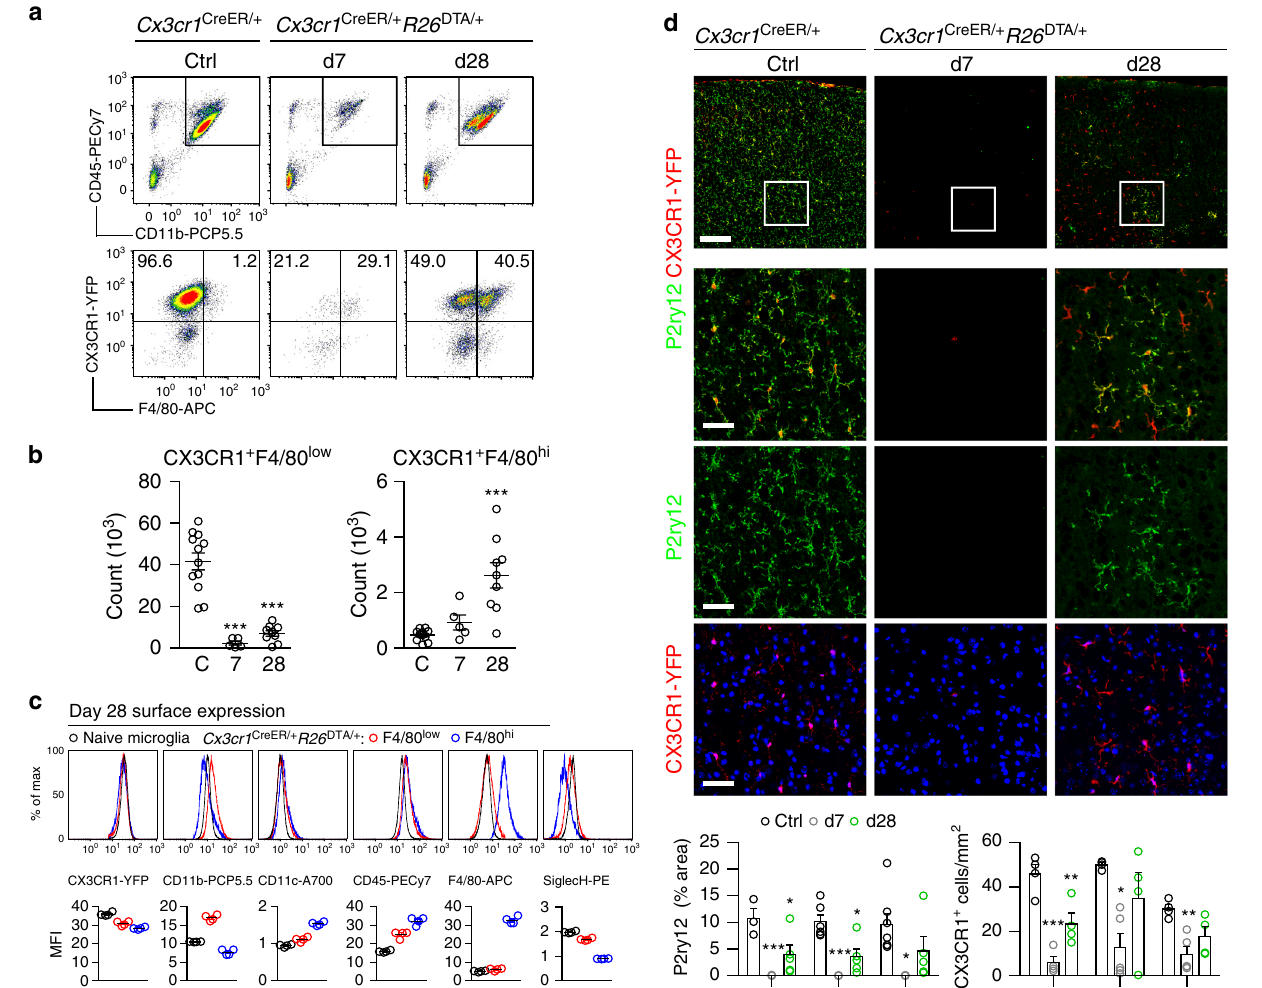
Fig. 1 Kinetics of depletion and repopulation of microglia in Cx3cr1 CreER/ + R26 DTA/ + mice. a Dot plots detailing depletion and repopulation of microglia in Cx3cr1 CreER/ + R26 DTA/ + mice on the indicated days after TAM administration. Top panel is gated on live singlet cells. Bottom panel is gated on CD11b + CD45 + Ly6C – Ly6G – . b Quanti fi cation of CX3CR1 + F4/80 low and CX3CR1 + F4/80 hi populations by fl ow cytometry. n = 12, 5, 9 mice, mean±s.e.m. *** p <0.001 by one-way ANOVA with Dunnett ’ s Multiple Comparison test. Data are pooled from three separate experiments. The experiment was repeated twice for each time point. c Surface expression by fl ow cytometry on repopulated F4/80 low and F4/80 hi cells at day 28 compared to naive microglia. Gated on CD11b + CD45 + Ly6C – Ly6G – . n = 4 mice/group. Lines represent mean values. The experiment was performed twice. d Quanti fi cation of P2ry12 and CX3CR1- YFP staining in the indicated brain regions. Representative images are from the cortex. n = 3 – 7 mice/group, mean±s.e.m. *** p <0.001, ** p <0.01, * p